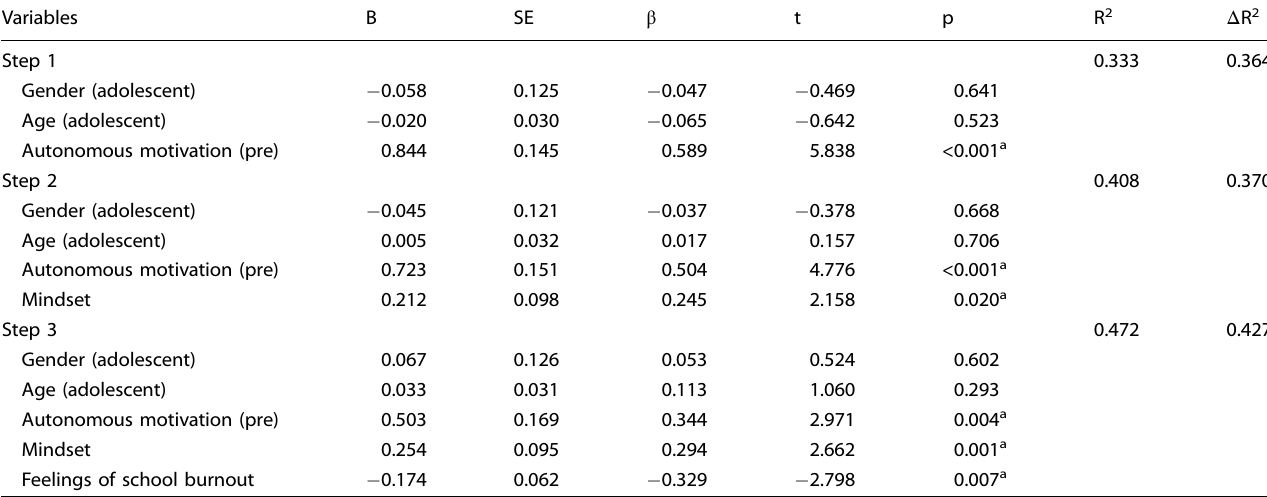
Table 2. Stepwise regression analysis of mindset and feelings of school burnout for autonomous motivation during home-based learning ( N = 97